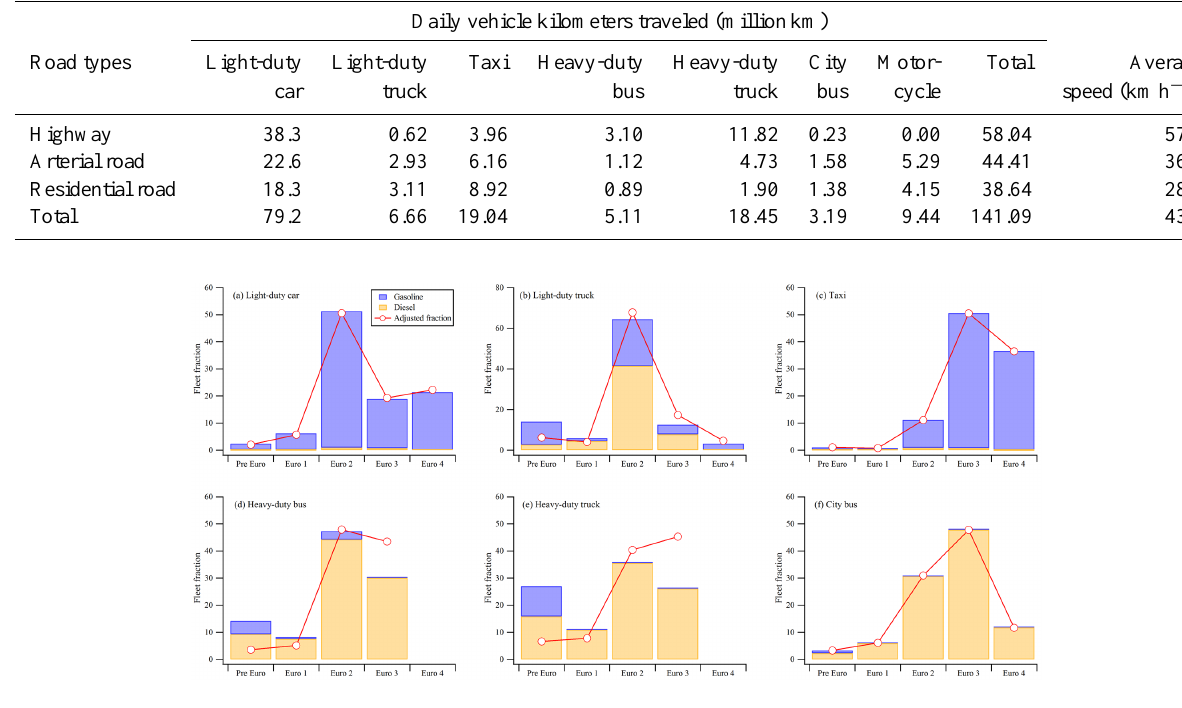
Figure 1. Static and adjusted fractions of each vehicle type in